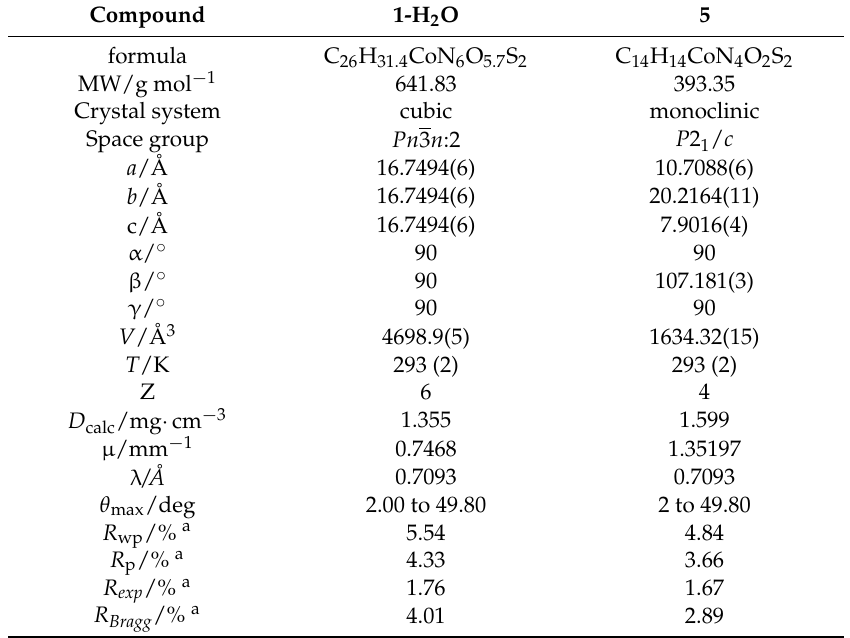
Table 2. Selected crystal data and details of the Rietveld refinements for compounds 1-H 2 O and 5 .